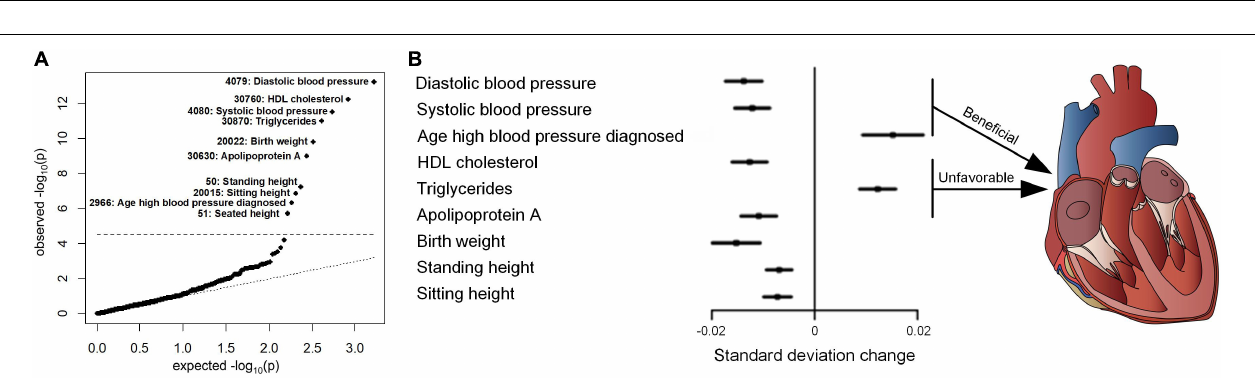
FIGURE 3 | Survival analyses of essential hypertension (A) or atrial fibrillation/flutter (B) incidence, all-cause and disease-related mortality by genotypes of rs1801253 (A) or rs4484922 (B) .